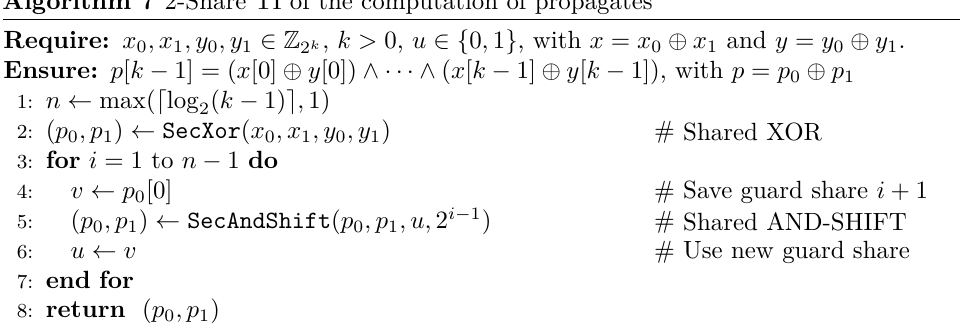
Algorithm 7 2-Share TI of the computation of propagates